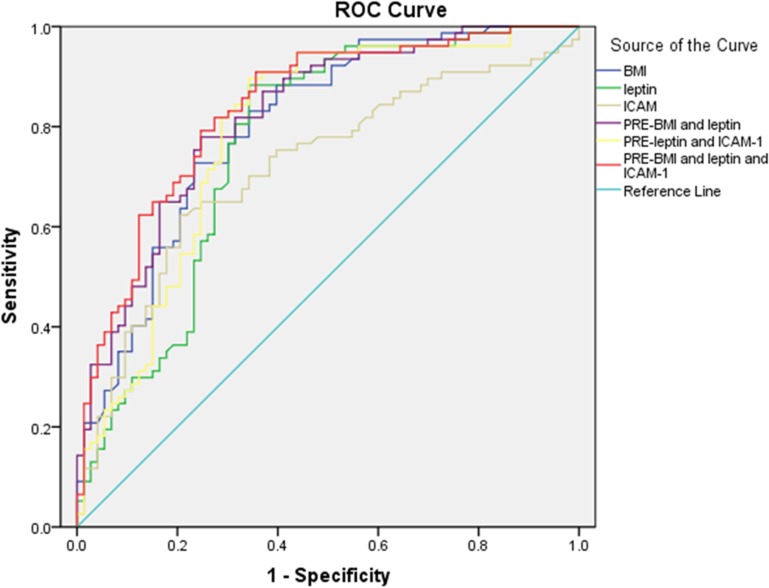
ROC curves for the association of BMI, leptin, and ICAM-1 or combined factors with the differential diagnosis of SA and TB.The concentrations of serum ICAM-1 and leptin obtained from ELISA analysis were used to establish ROC curves to identify SA (n = 89) and TB (n = 89).